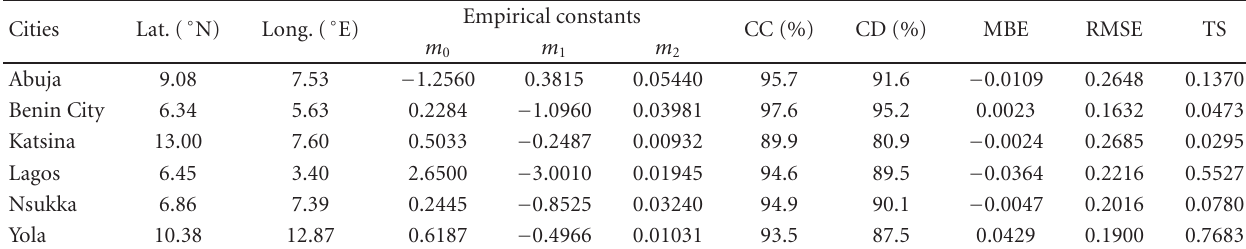
Table 1: Results of stochastic analysis on temperature-based linear regression model of (1) along with the geographical locations for selected cities in